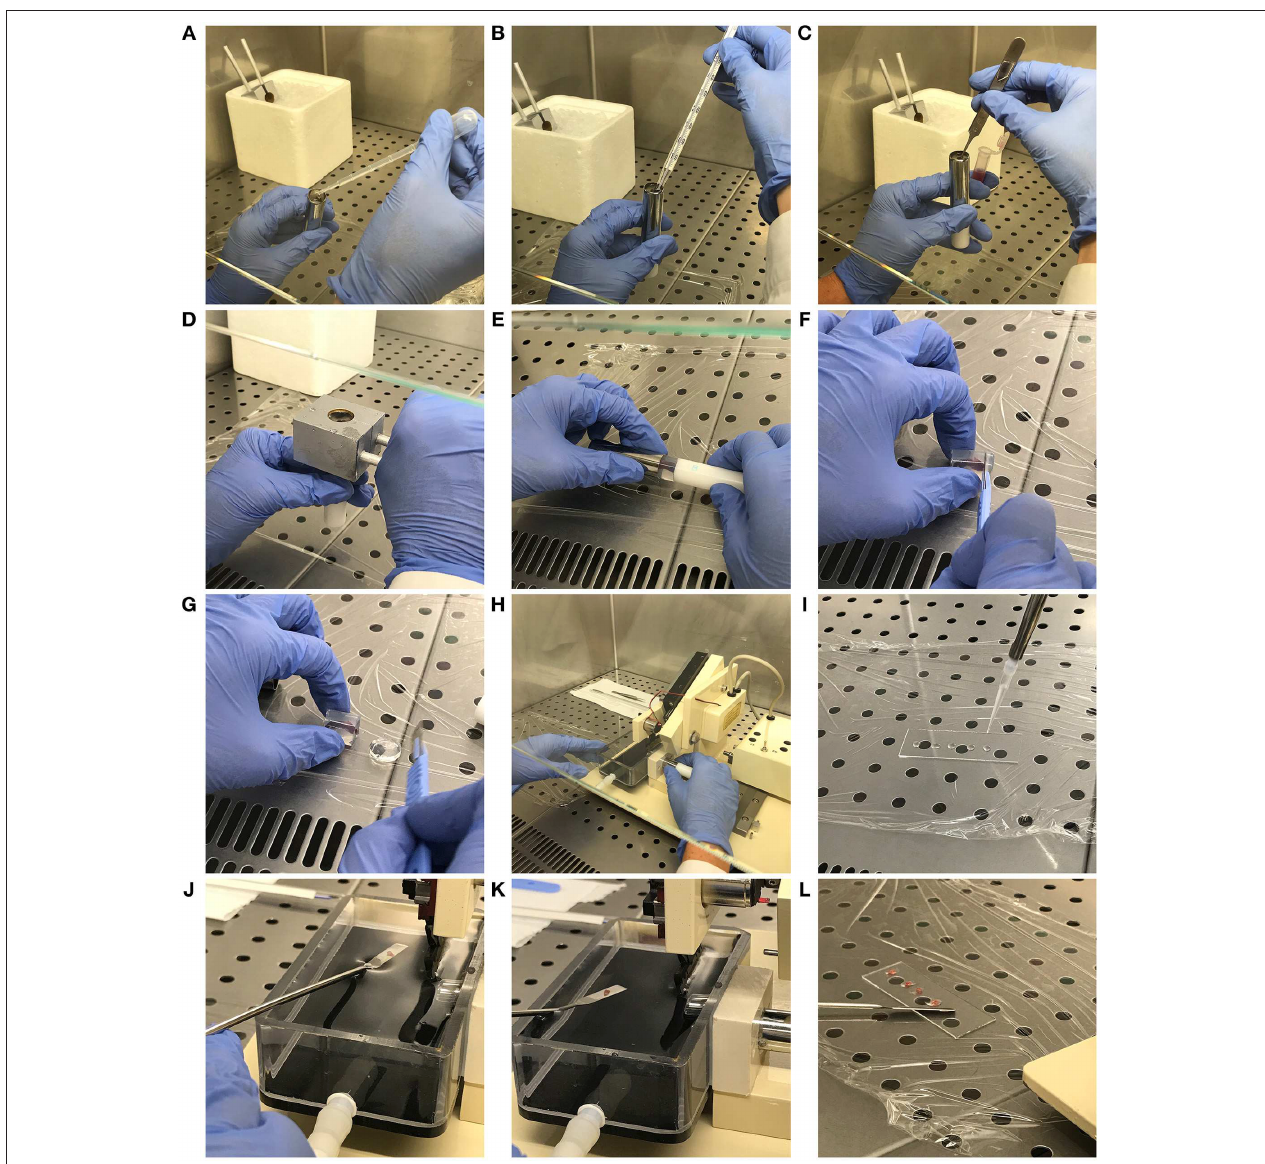
FIGURE 1 | Mouse spleen inclusion in agarose and precision-cut: step-by-step description of the protocol. (A) Syringe chilling block pre-cooling and specimen tube filling. (B) Agarose temperature checking. (C) Spleen inclusion into the agarose block. (D) Chilling of the spleen-containing agarose block. (E) Extraction of the agarose block containing the embedded sample. (F,G) Exceeding agarose removal from the agarose block. (H) Specimen tube insertion into the sample housing. (I) Preparation of the microscope slide with PBS drops. (J,K) Spleen slice preparation and recovery from the buffer tank with a spatula. (L) Spleen slice transfer in the PBS drops of the microscope